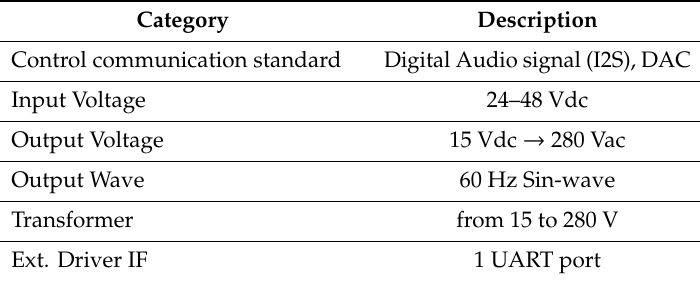
Table 4. Specification of SPD control device.